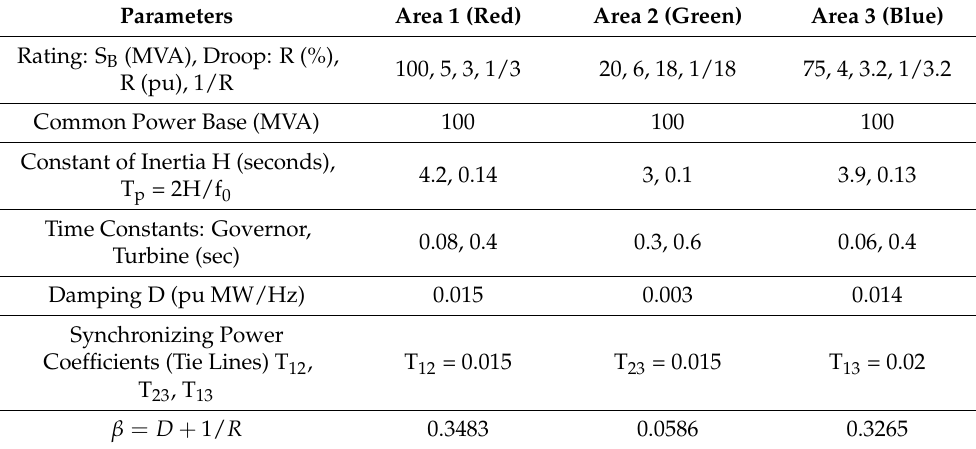
Table 1. System Parameters.